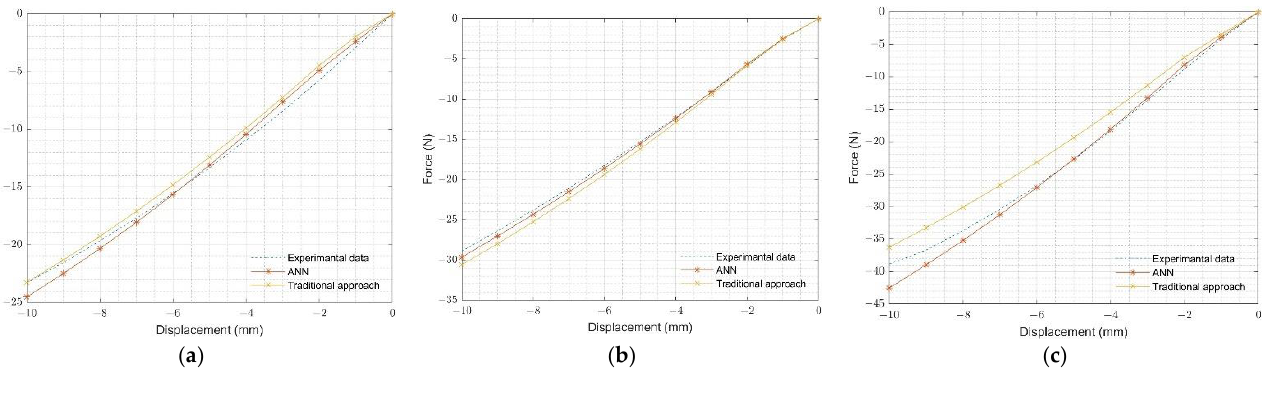
Figure 11. Comparison of experimental and FEA results: ( a ) neoprene rubber O-ring tension test, ( b ) natural rubber O-ring tension test, ( c ) silicone rubber O-ring tension test, ( d ) neoprene rubber O- ring compression test, ( e ) natural rubber O-ring compression test, and ( f ) silicone rubber O-ring compression test.